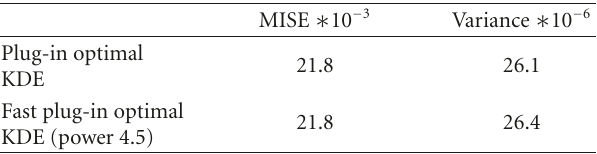
Table 4: MISE and variance of 100 simulations of the theoretical distribution using the two studied KDE.